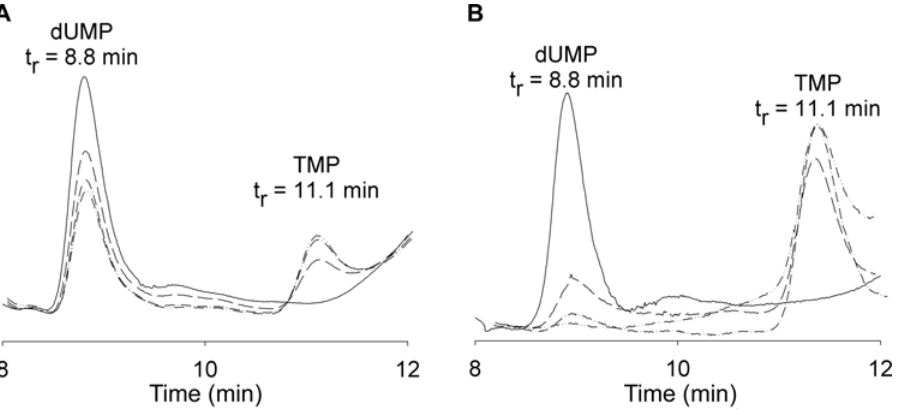
Figure 4. HPLC analysis of M.tuberculosis ThyA and ThyX products. (A) M. tuberculosis ThyA reaction products. Based on absorbance at 260 nm, the peak corresponding to dUMP (t r =8.8 min) decreases while the peak corresponding to TMP (t r =11.1 min) increases over a 120 minute time course (0, 30, 60, and 120 minute time points). (B) M. tuberculosis ThyX reaction products. The peak corresponding to dUMP (t r =8.8 min) decreases while the peak corresponding to TMP (t r =11.1 min) increases over a 120 minute time course (0, 30, 60, and 120 minute time points).